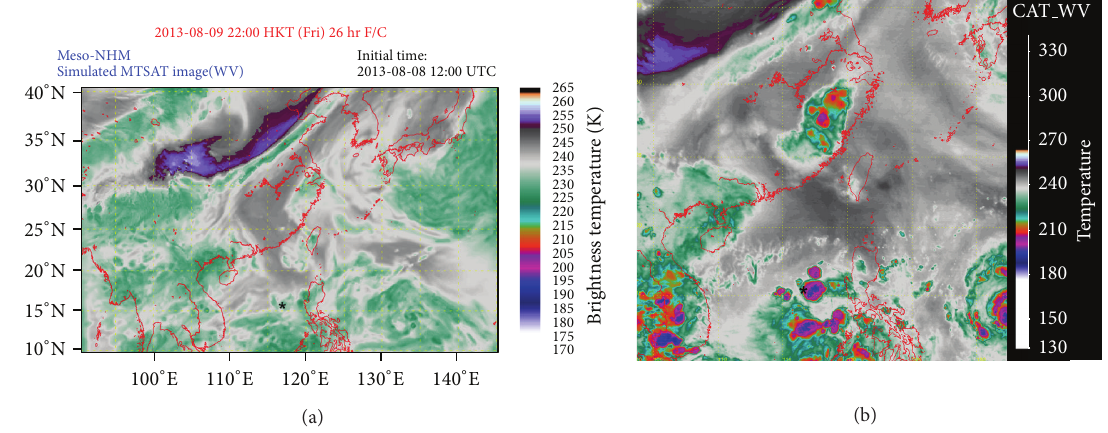
Figure 11: Simulated water vapour image (a) at 1400 UTC, 9 August 2013, and MTSAT image (b) at 1332 UTC. The asterisk shows the location of the turbulence